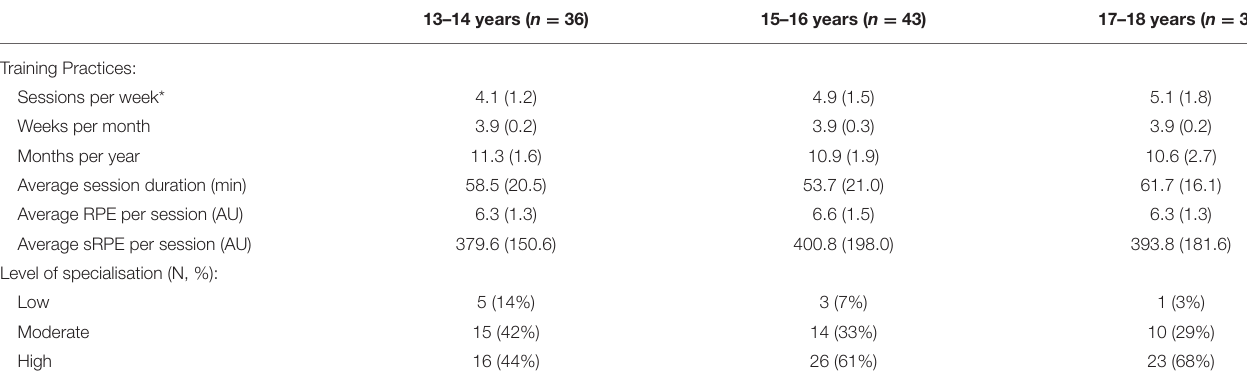
TABLE 3 | Training practices and level of specialisation according to age-group (data presented as mean and SD, unless otherwise